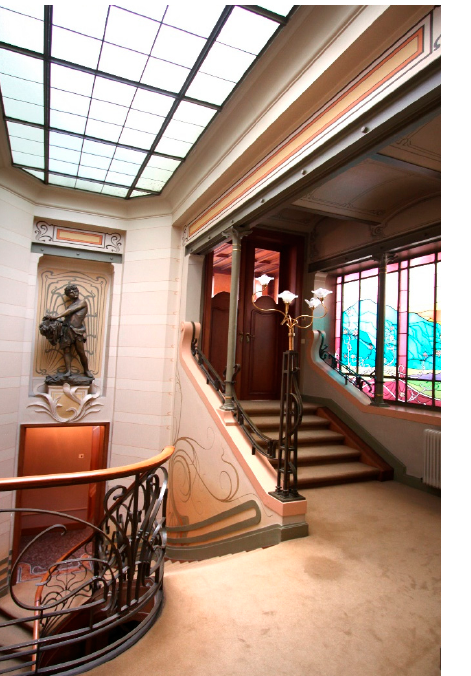
Figure 6. The effect of verticalism and biomorphic interior design observed in the Horta House.